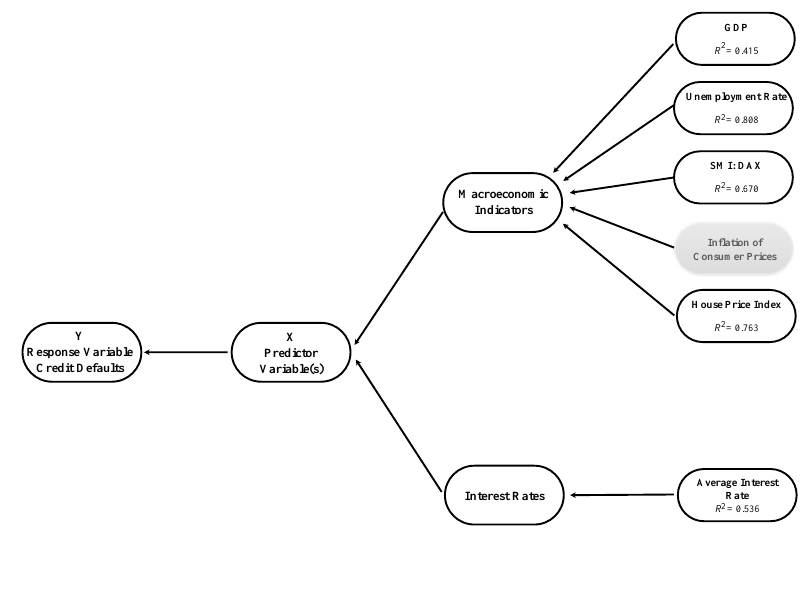
Fig. 5. The model of results for the German Market (developed by the